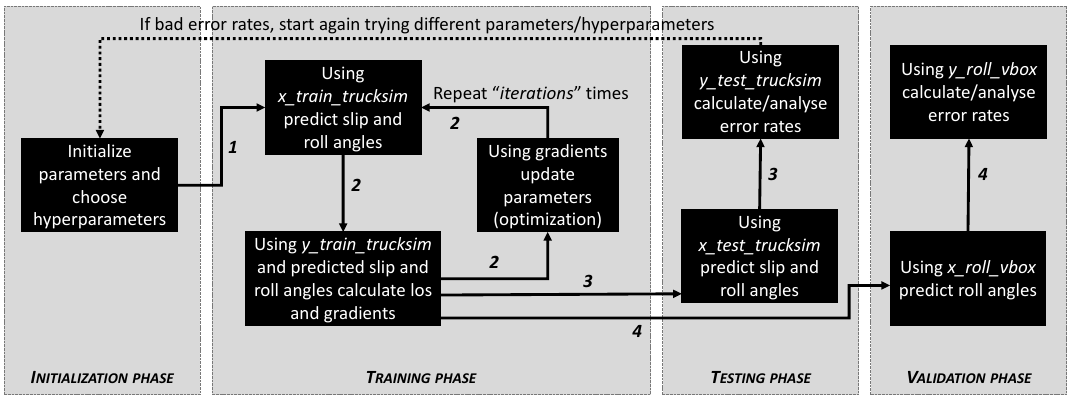
Figure 5. Deep learning approach